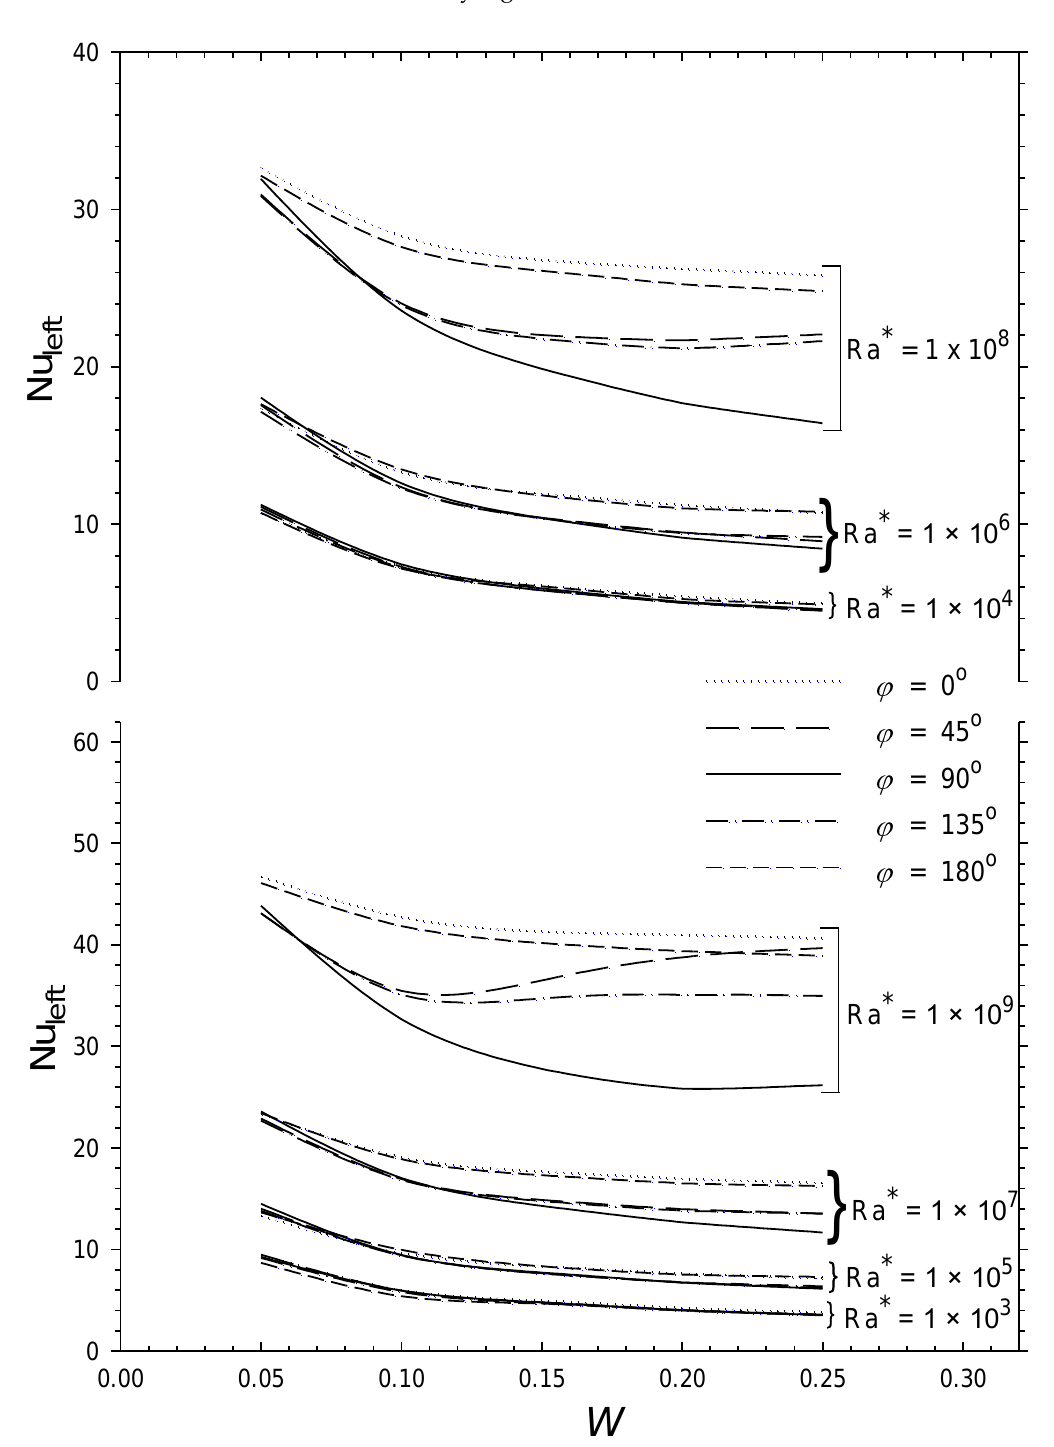
Figure 7. Variations in the mean Nusselt number of the left-side surface of the slender cuboid with dimensionless width, W , for different values of the heat flux Rayleigh number, Ra *, and positions, φ .